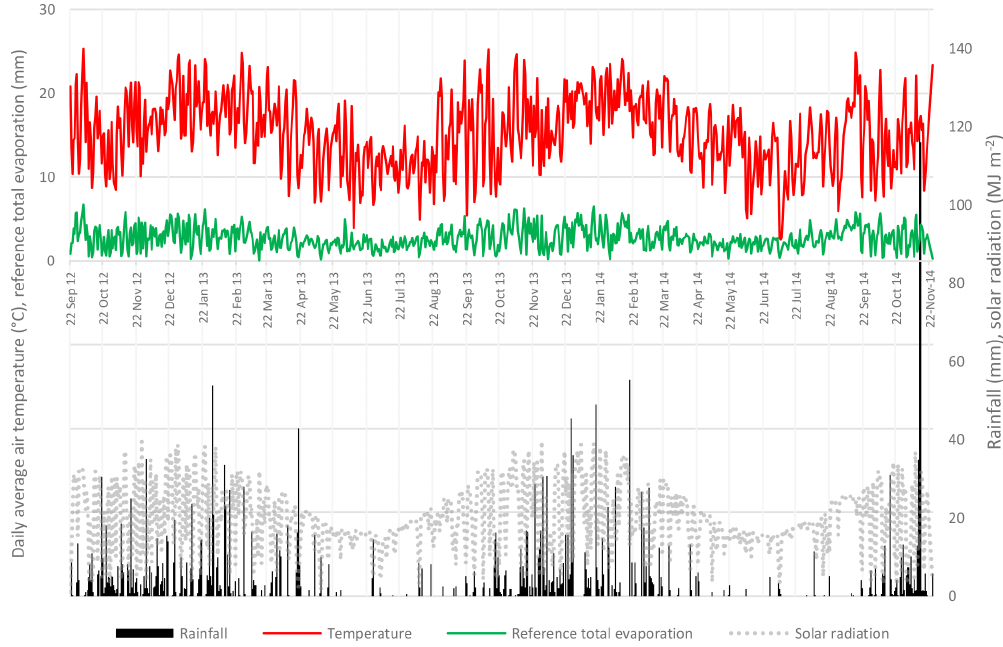
Figure 2. The daily rainfall, solar radiation, average air temperatures and reference total evaporation at New